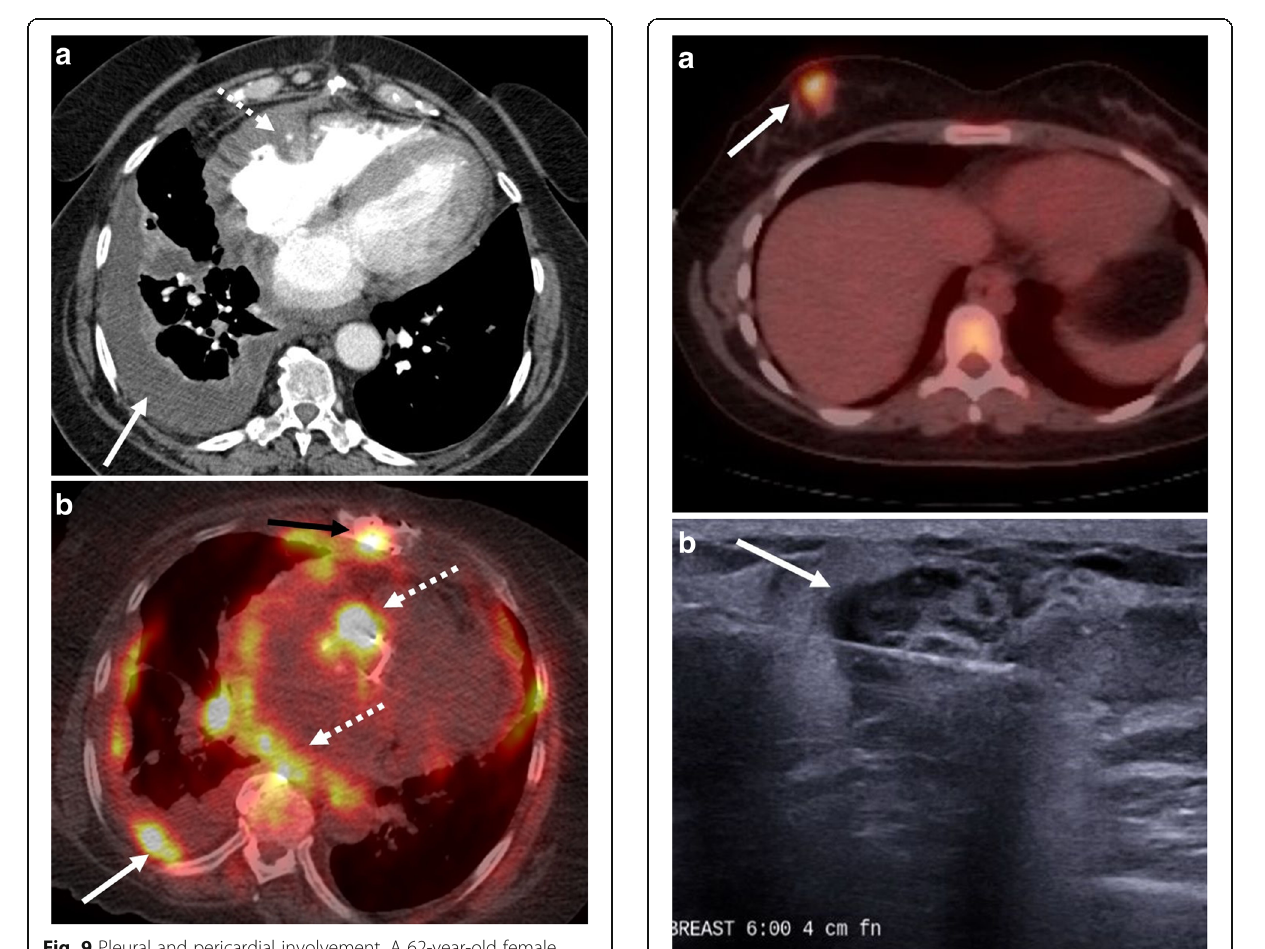
Fig. 9 Pleural and pericardial involvement. A 62-year-old female presenting with chest pain and shortness of breath. a Contrast- enhanced axial CT image demonstrates a partially loculated right pleural effusion (solid arrow) and mass-like thickening of the pericardium extending into the epicardial fat encasing the right coronary artery (dashed arrow). b Fused axial PET-CT demonstrates associated hypermetabolic uptake within the pericardial mass (white dashed arrows) and better depicts multifocal right-sided pleural involvement (white solid arrow). There is also sternal involvement (black solid arrow)